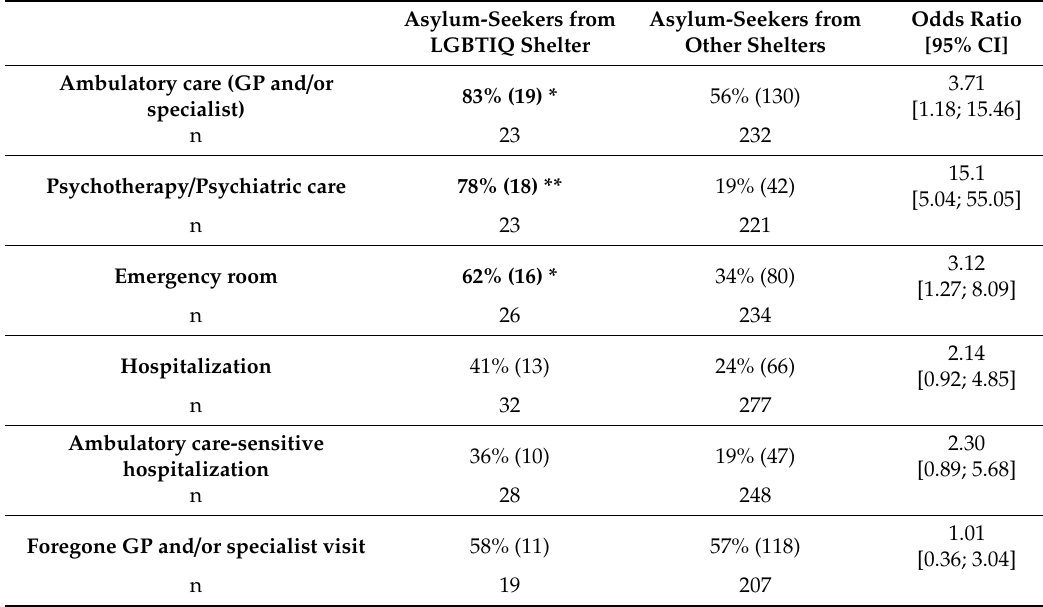
Table 3. Healthcare Utilization and Access (in % (n) of respondents reporting at least one visit / occurrence in the previous 12